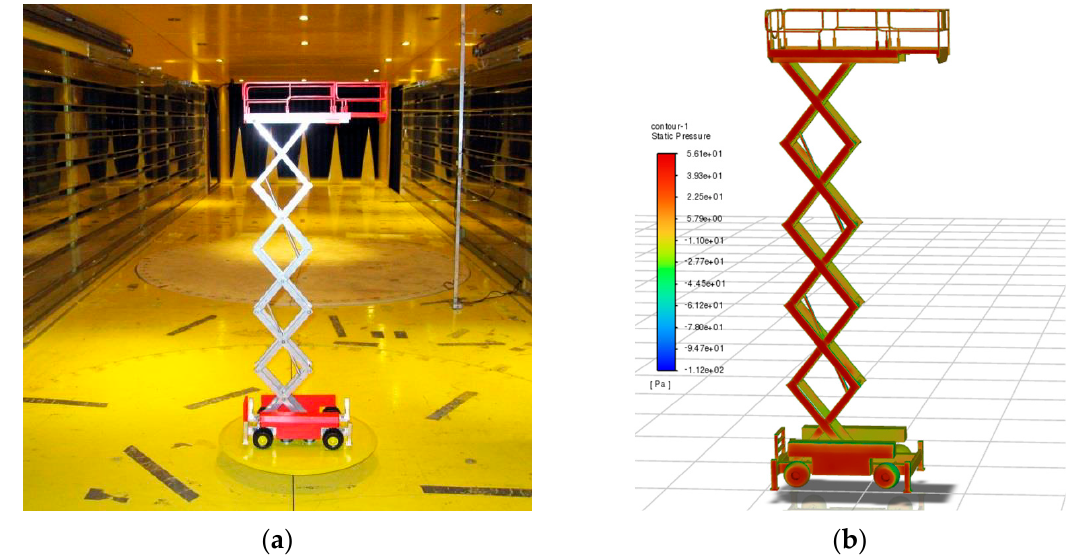
Figure 4. Model of the scissor lift at maximum working height with extended roll-out deck (conf. 1): ( a ) During the aerodynamic tests, ( b ) the CFD simulation.